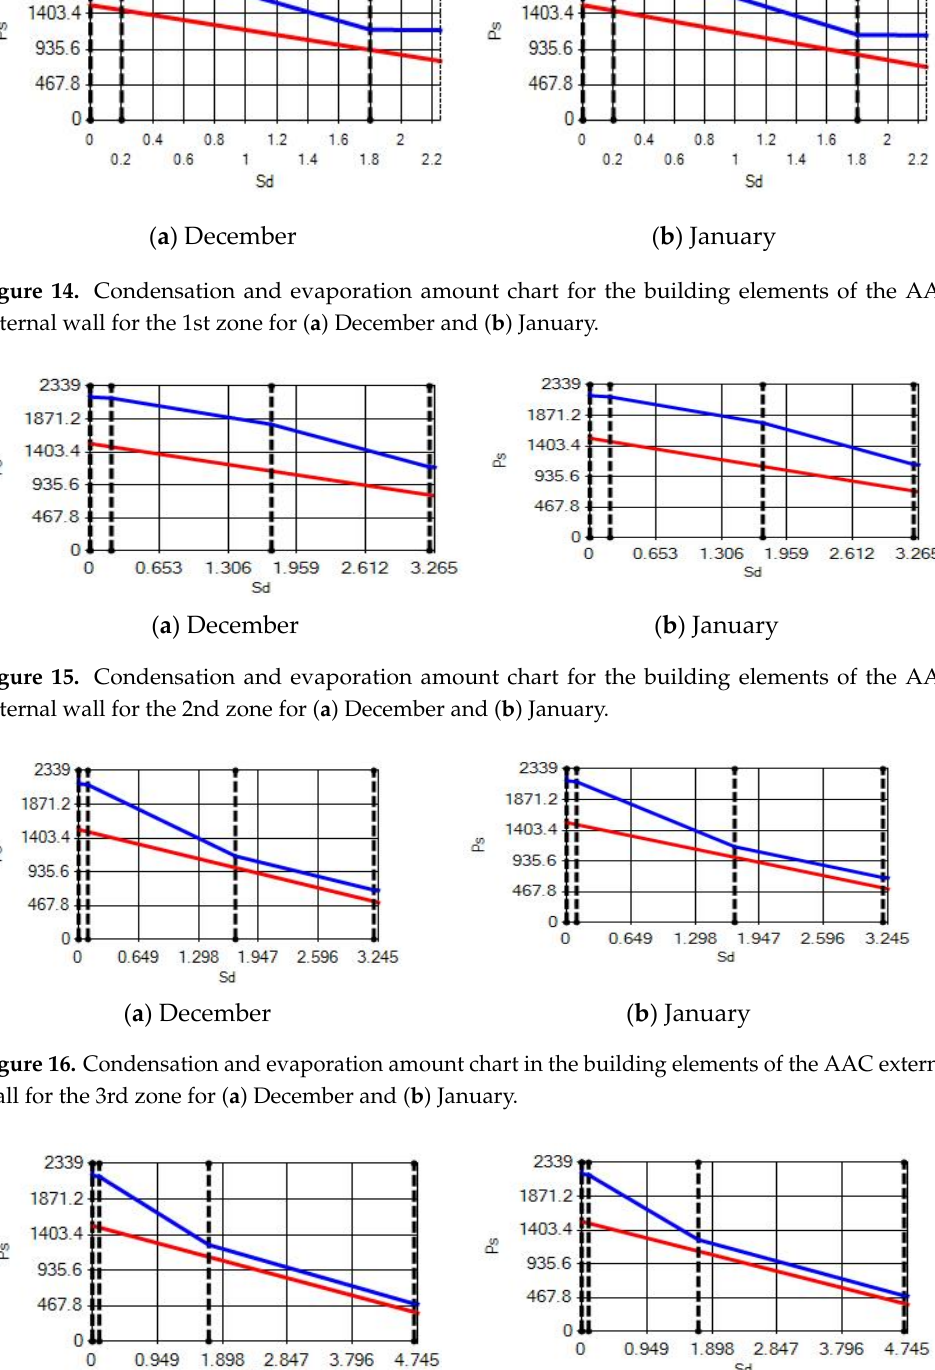
( b ) January Figure 18. Condensation and evaporation amount chart in the building elements of the brick external wall for the 1st zone for ( a ) December and ( b ) January. Commensurate to all results obtained from the analysis, no condensation occurred in the building element according to TS 825. Since the temperature deviation between the inner surface and the indoor environment is less than 3 degrees in exterior walls made using AAC, it shows conformity with the ordinances. According to the results obtained from the analysis, no condensation occurred in the building element according to TS 825. Since the temperature difference between the inner surface and the indoor environment is less than 3 degrees in exterior walls made using AAC, it follows the regulations. ( a ) December ( b ) January Figure 19. Condensation and evaporation amount chart for the building elements of the brick ex- ternal wall for the 2nd zone for ( a ) December and ( b ) January.